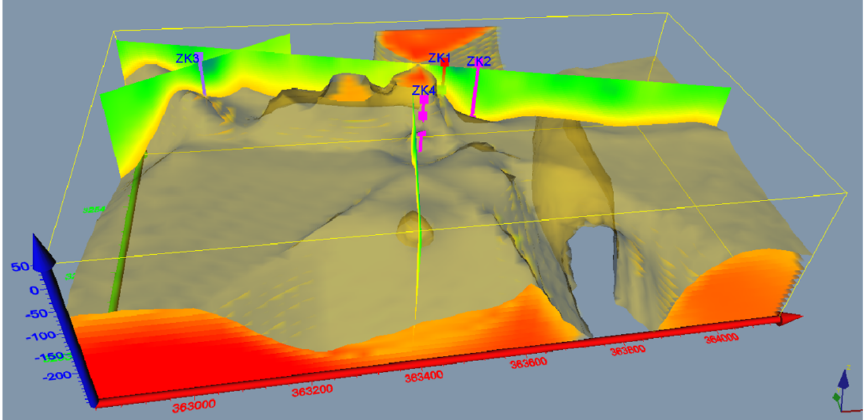
Figure 11. Pseudo − 3D resistivity in Huarong County, Nanshan Township.